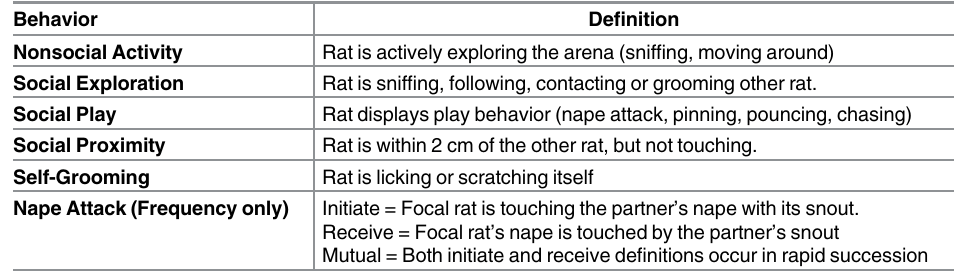
Table 2. Social Dyad Ethogram.